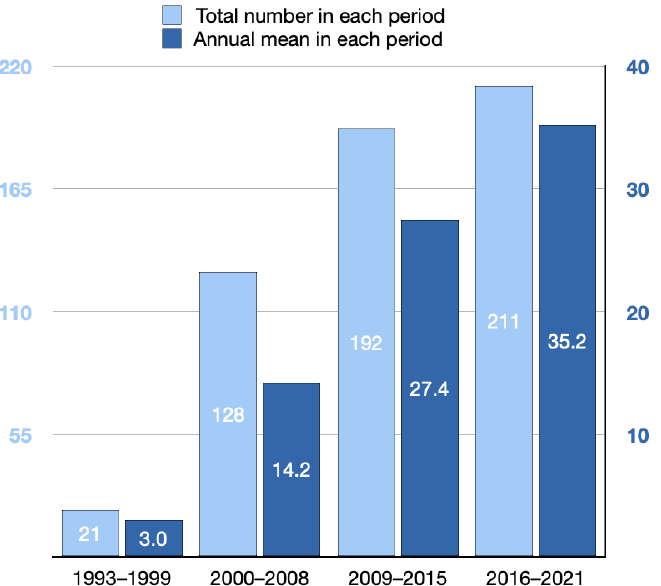
Figure 3. Changes in the number of palliative-associated research and annual mean in different periods.